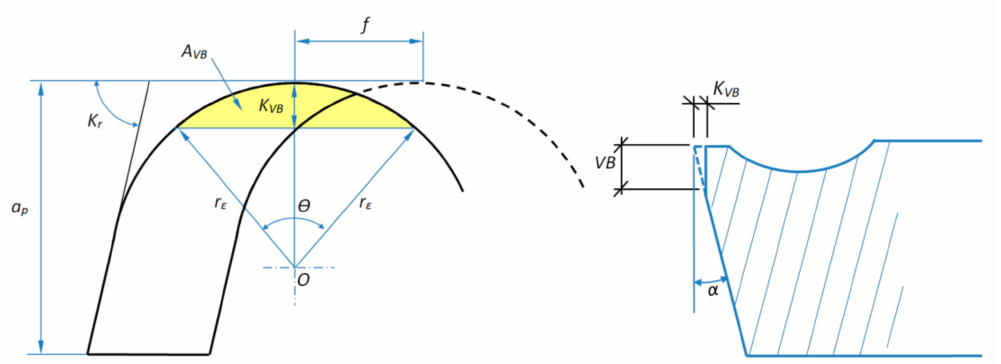
Figure 15. Diagram of the change of cross-section area of the cutting layer resulting from the wear of the cutting